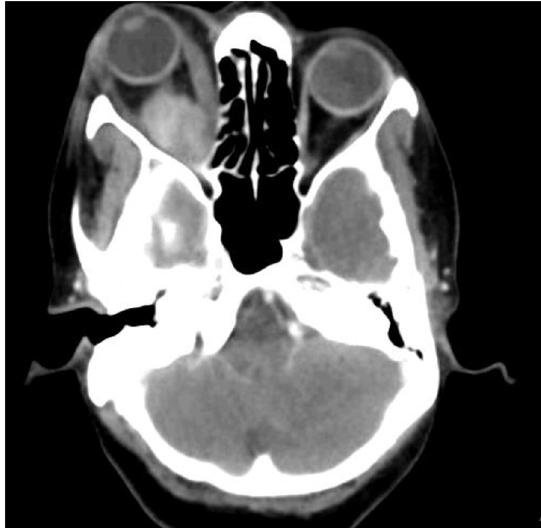
Fig. 1 Contrast-enhanced CT showing a 3 enhancing mass arising from the inferior rectus muscle with